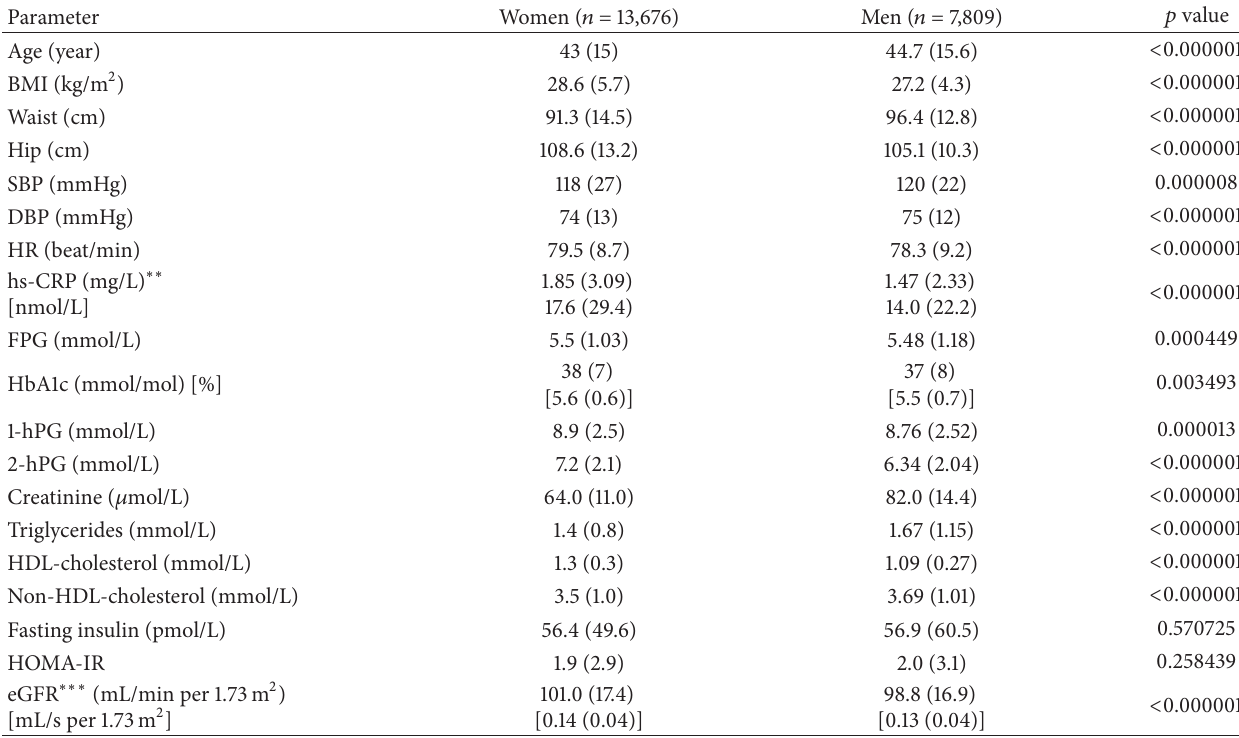
Table 1: Clinical characteristics and laboratory findings of TURDEP-II study population ∗